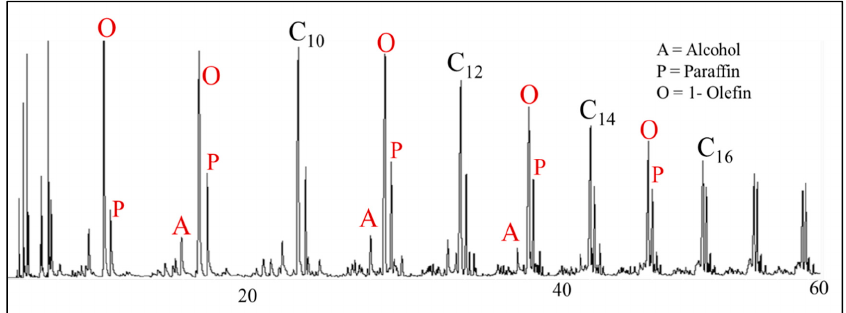
Figure 29. The observed deviations in the 1-olefin/total olefin ratio, by altering the iron catalyst recipe, are most likely due only to the different amounts of potassium. Copper and silica do not affect the olefin ratio observed in the product selectivity. Reaction Conditions: 270 °C, 12.1 bar, WHSV = 2, and H 2 /CO = 0.7.